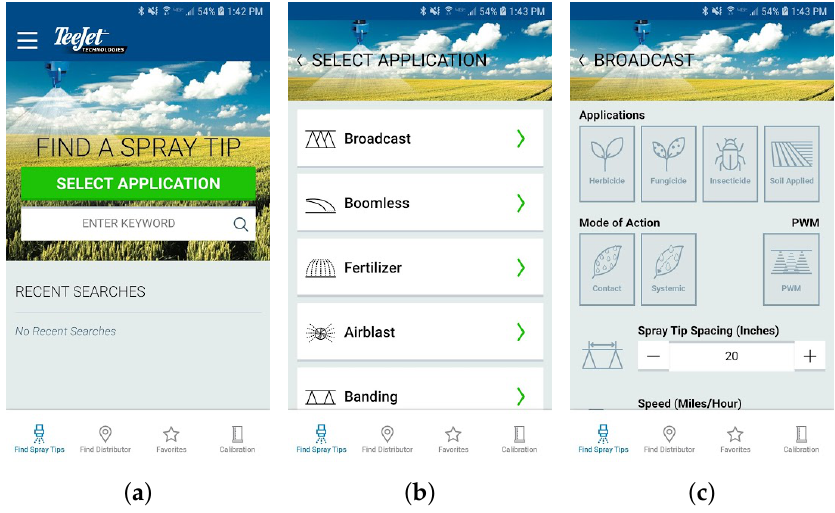
Figure 13. SpraySelect: ( a ) Application type selection menu; ( b ) Interface that allows to set the speed, spacing, target rate and droplet size category values; ( c ) List of recommended nozzles.